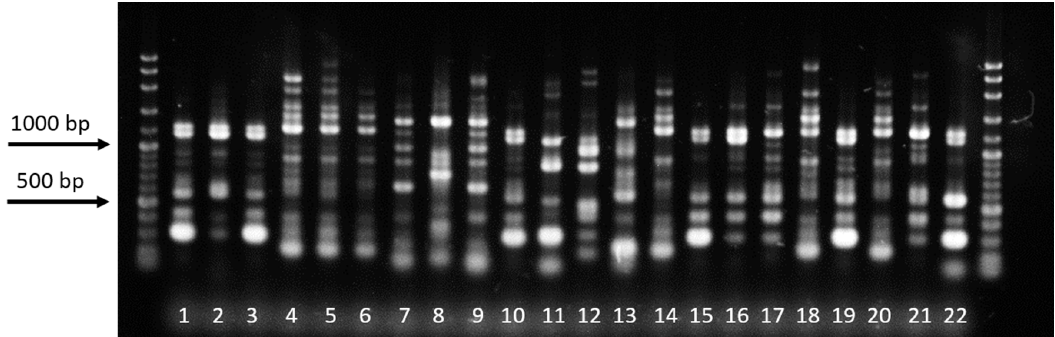
Figure 8. Examples of fingerprint patterns generated by BOXA1R primer. Lanes 1–3 and 10, 4–6, 7–9, and 11–13 show the fingerprint patterns produced from Rhizoctonia solani , R. oryzae-sativae , R. oryzae , and Ceratobasidium sp., respectively.